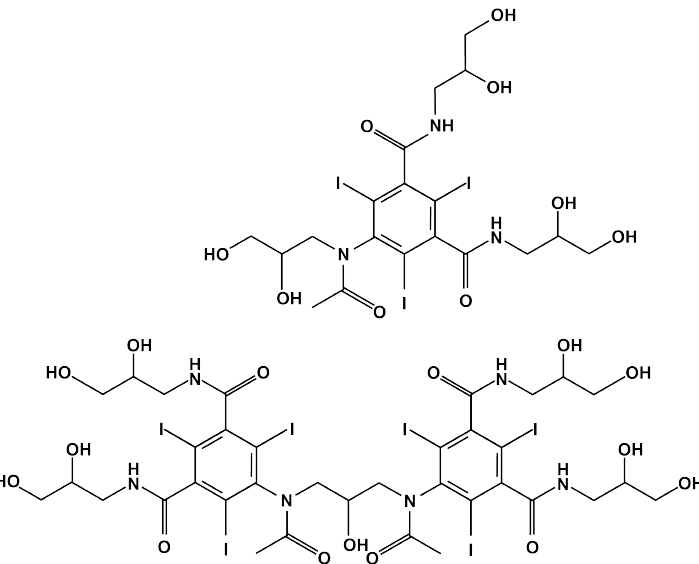
Figure 1. Structures of iodine-containing radiopaque substances.